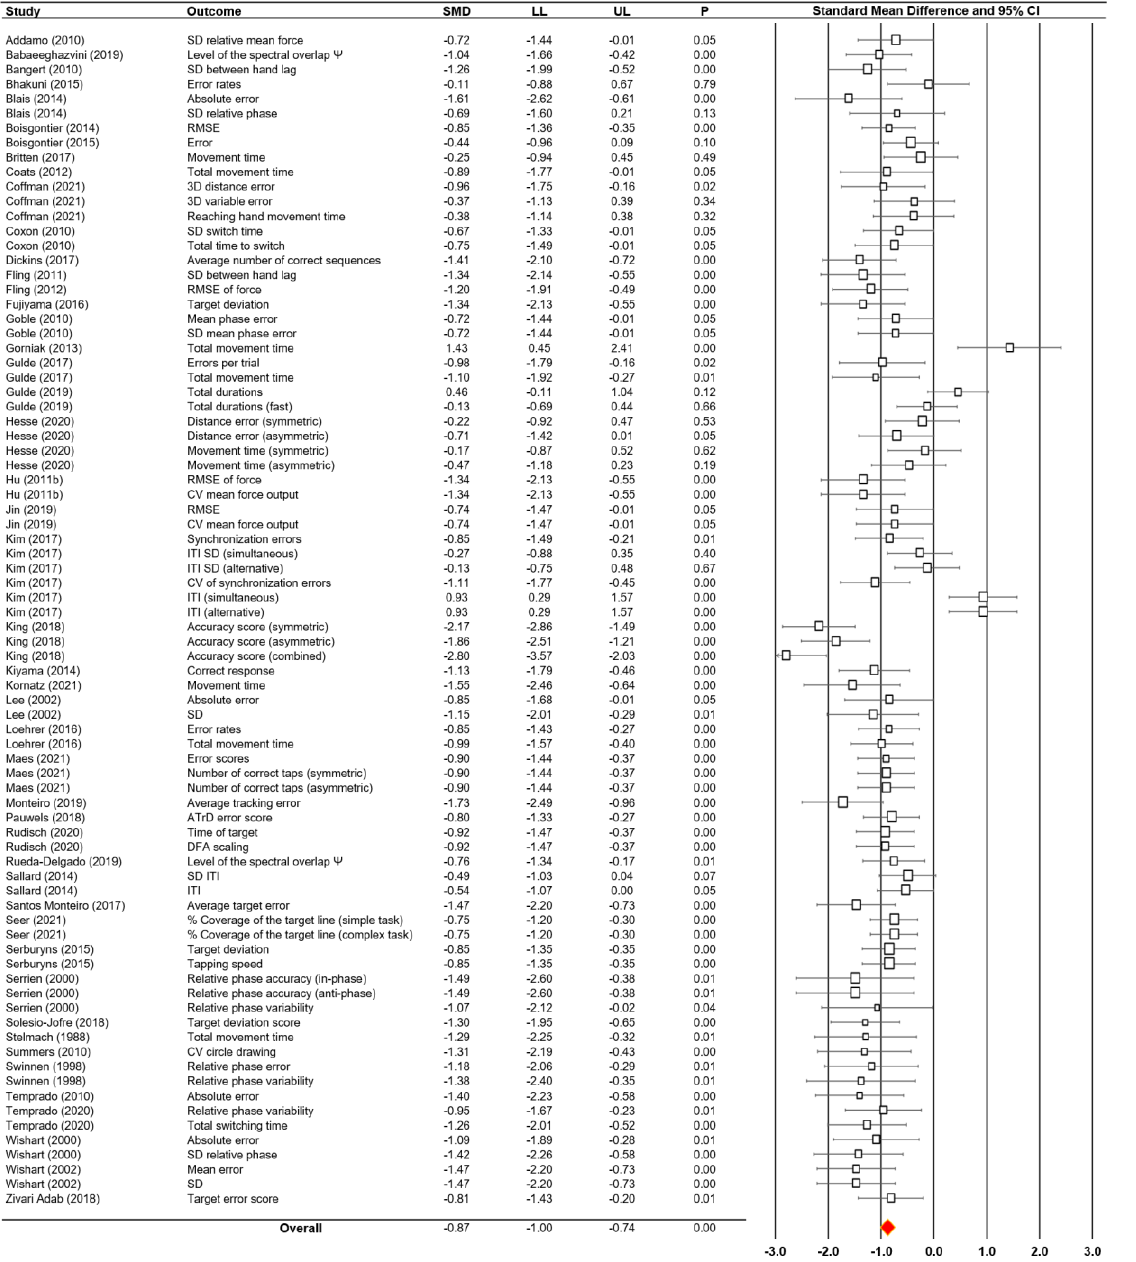
Figure 2: Meta-analysis findings and forest plot for bimanual motor performance in older adults versus younger